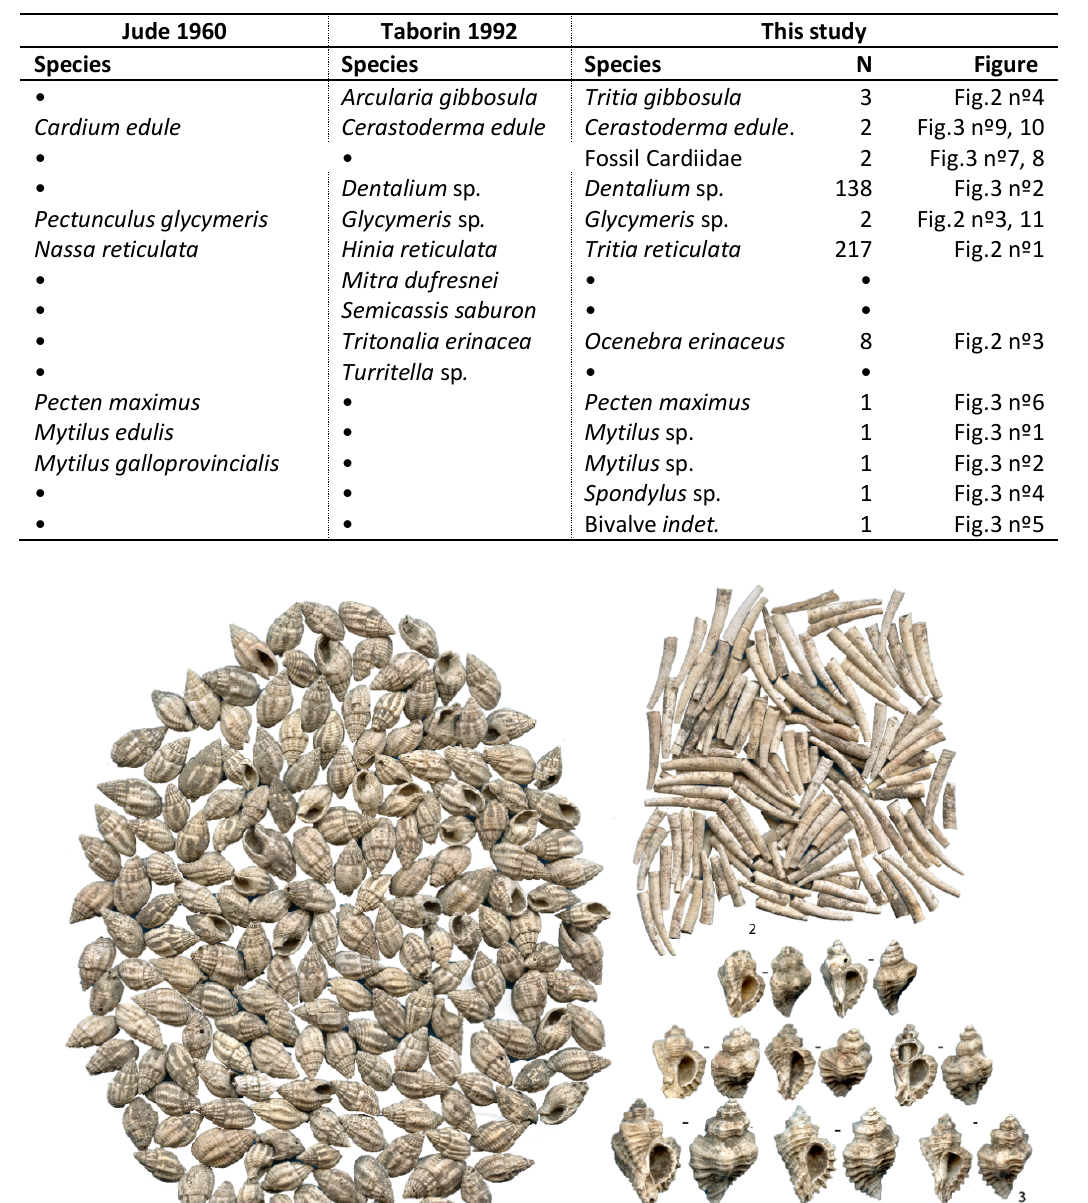
Table 2: Shell species identified in the Upper Magdalenian layer II of Rochereil.